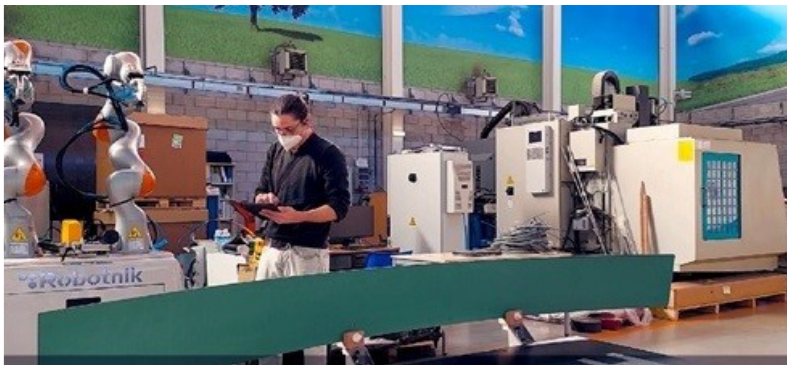
Figure 3. Scenario of the Use case 1: Cobot Learning from Demonstration (LfD).